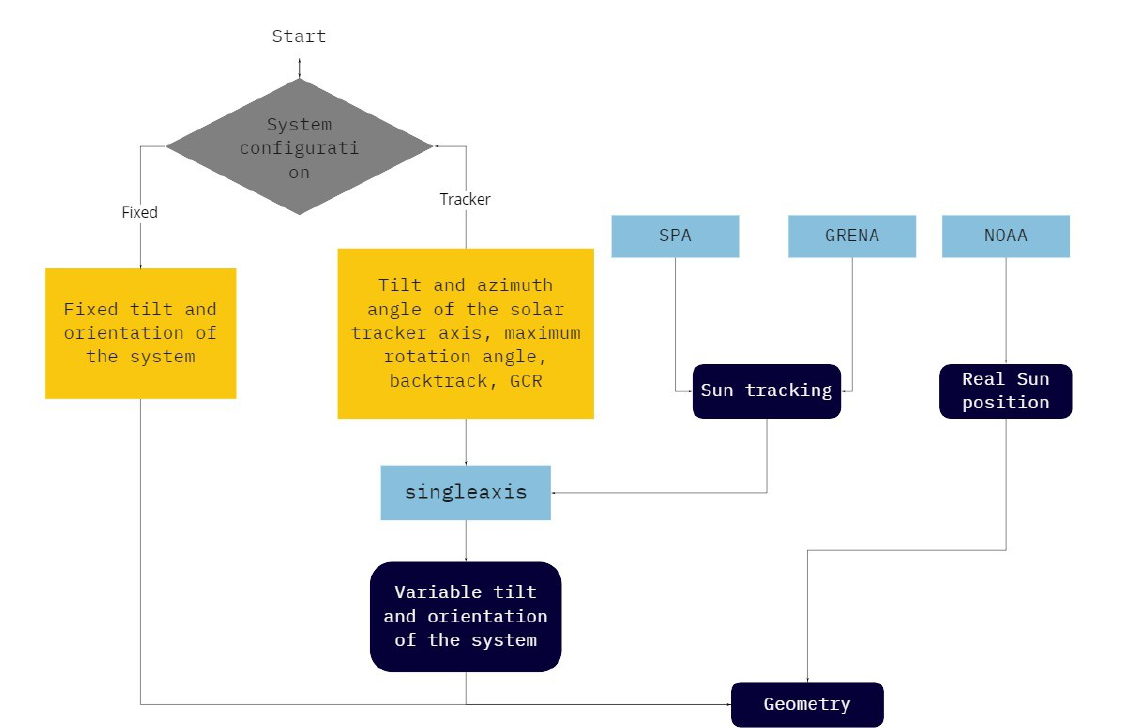
Figure 2. Algorithm block diagram for the geometry